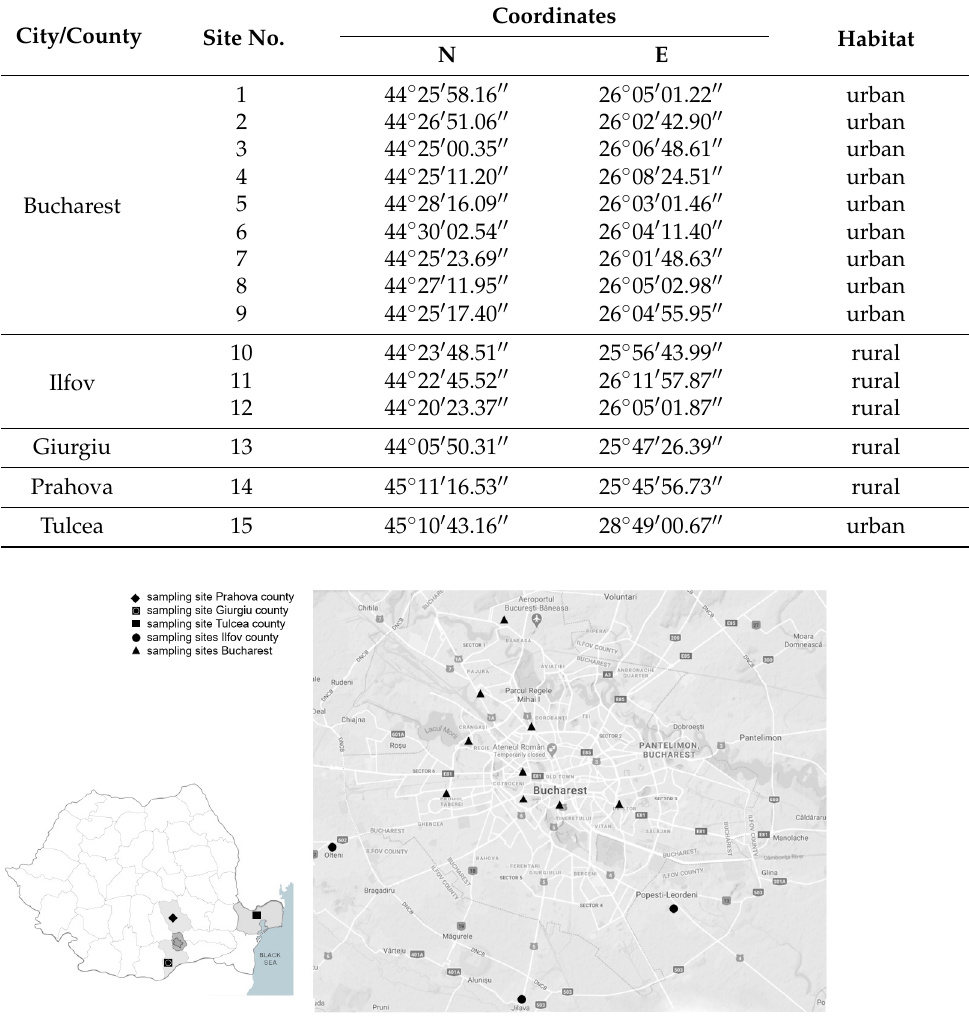
Figure 1. Map of mosquito sampling sites, south-eastern Romania, 2018–2019.